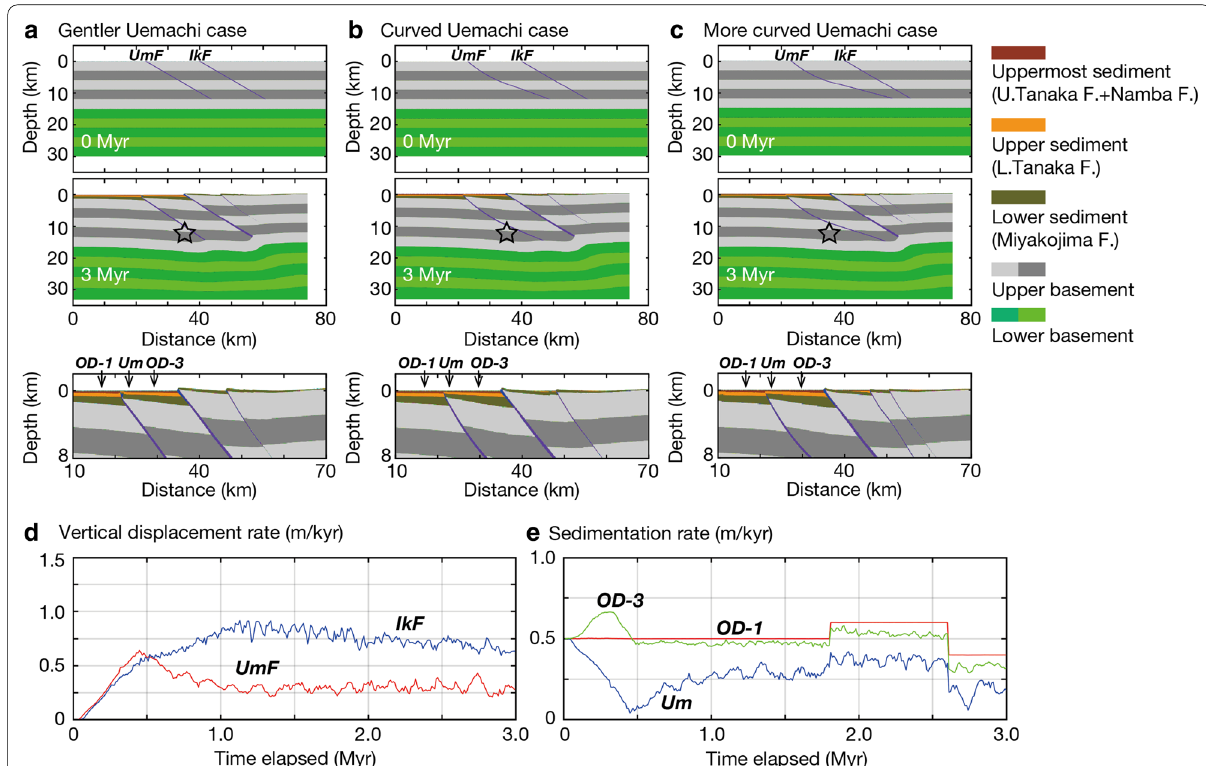
Fig. 11 Effect of changing the dip angle of the western fault (i.e., the Uemachi fault) on the development of the geologic structures. a–c The initial geometry (upper), final geometry (middle), and close-up of the final geometry (lower) of the linear fault case with a dip angle of 30° ( a ), the curved fault case ( b ), and the more curved fault case ( c ). The preexisting faults and newly formed faults (markers with a cumulative strain larger than 1) are illustrated in dark blue. UmF and IkF represent the surface positions of the Uemachi and Ikoma faults, respectively. The hypocenter of the 2018 northern Osaka earthquake (Kato and Ueda 2019), located 12 km beneath the surface position 14 km east from the Uemachi fault, is indicated by a star in the panels showing the result at 3 Myr. OD-1, Um and OD-3 indicate the location of the OD-1, OD-9 and OD-3 core sites, respectively. d Time evolution of the vertical displacement rates along the western and eastern faults for the curved case. e Time evolution of the sedimentation rates in the Uemachi Upland (i.e., at the location of the OD-9 core site) and at the location of the OD-3 core site for the curved case. The imposed sedimentation rates at the location of the OD-1 core site are also